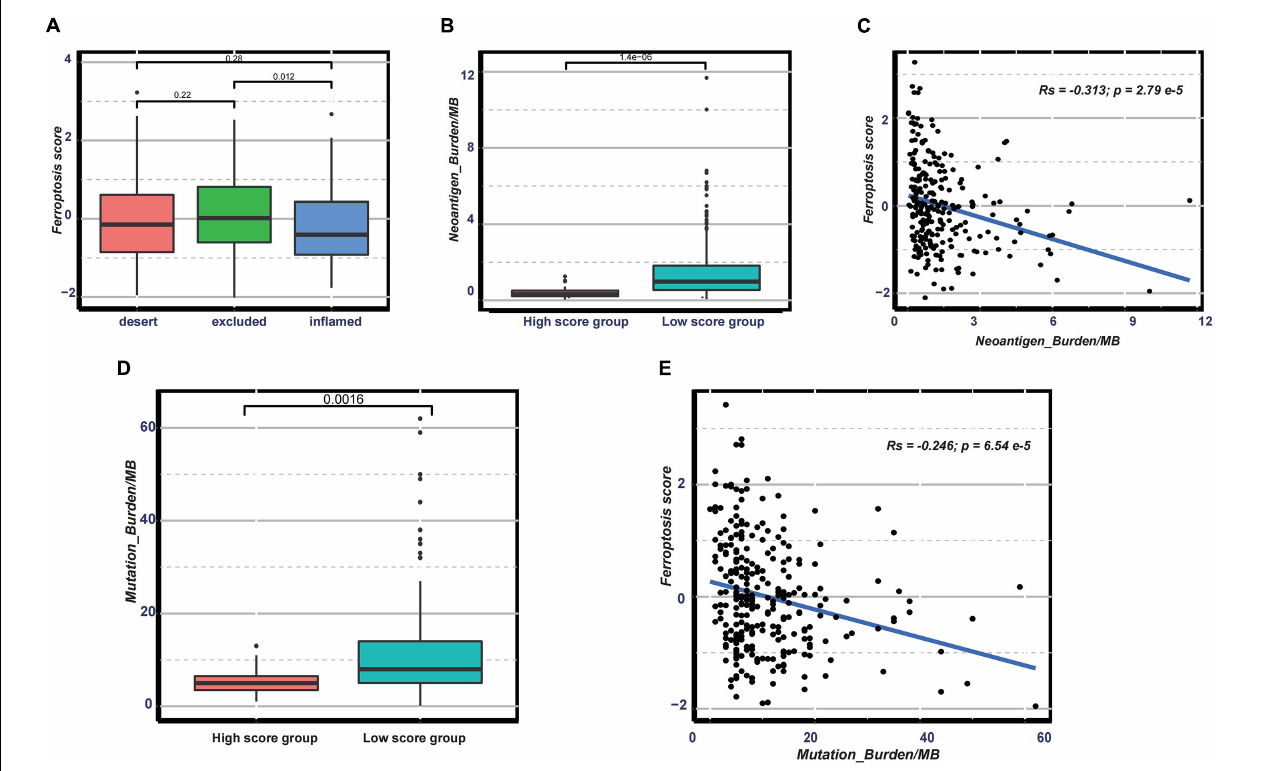
FIGURE 8 | (A) Distribution of the ferroptosis scores in distinct immune subtypes in the immunotherapy cohort. (B–E) Distribution of the neoantigen burden (B) and tumor mutation burden (D) in groups with low or high ferroptosis scores and correlations between the ferroptosis score and neoantigen burden (C) and between the ferroptosis score and tumor mutation burden (E)